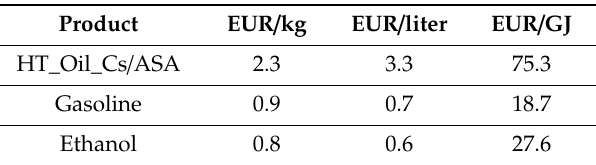
Table 3. Comparison of minimum viable price of fuel product from pyrolysis with market price of gasoline and of first-generation ethanol.